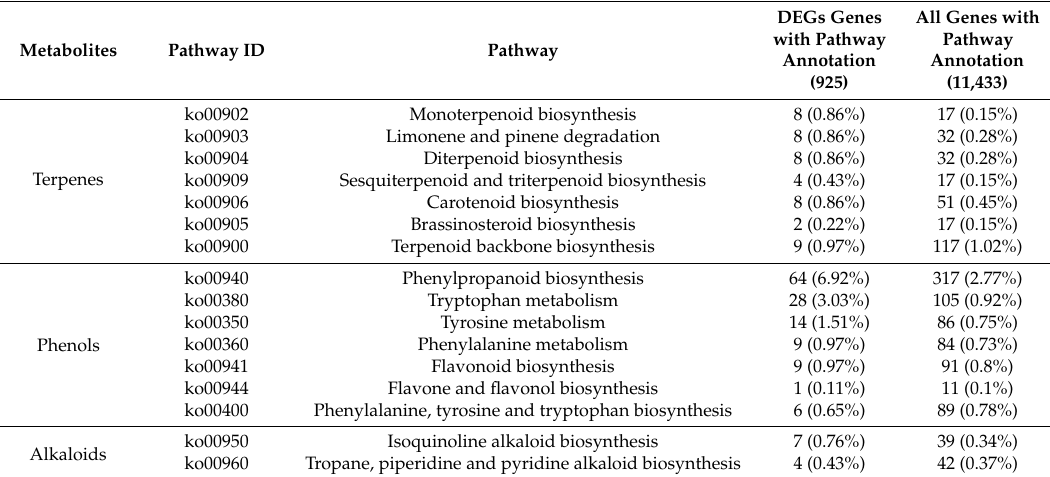
Table 3. Enriched pathways involved in secondary metabolism.